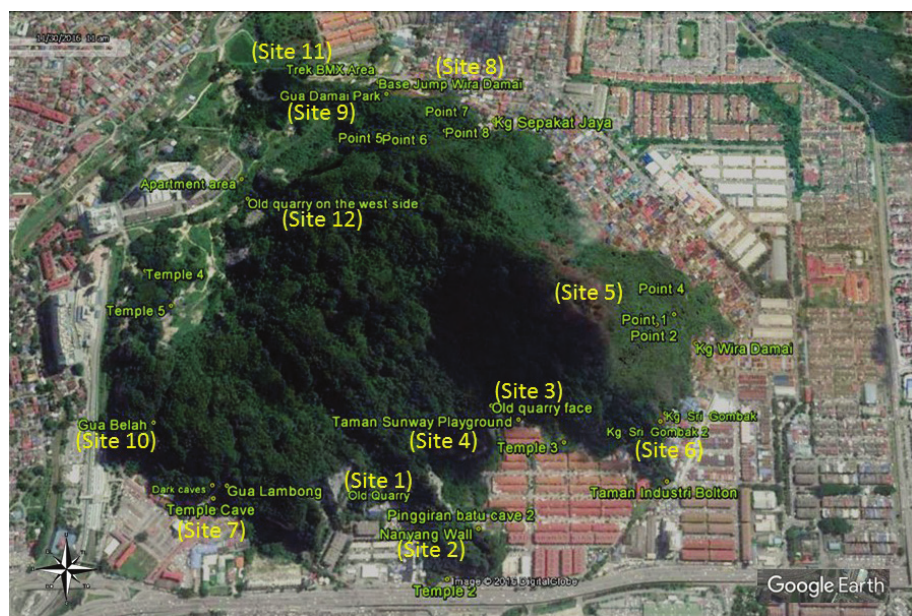
Figure 1. Study sites on Batu Caves, a limestone karst in Selangor, Peninsular Malaysia (Google